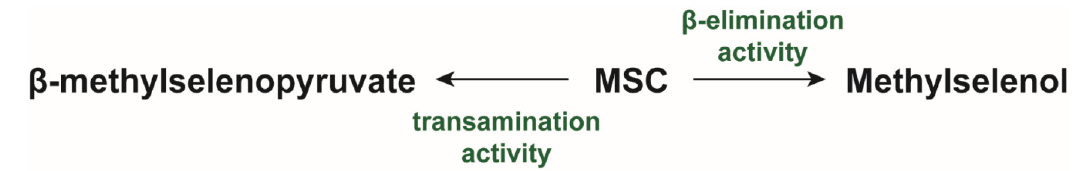
Figure 1. Schematic representation of β -elimination and transamination activity of the kynurenine aminotransferase 1 (KYAT1) enzyme.